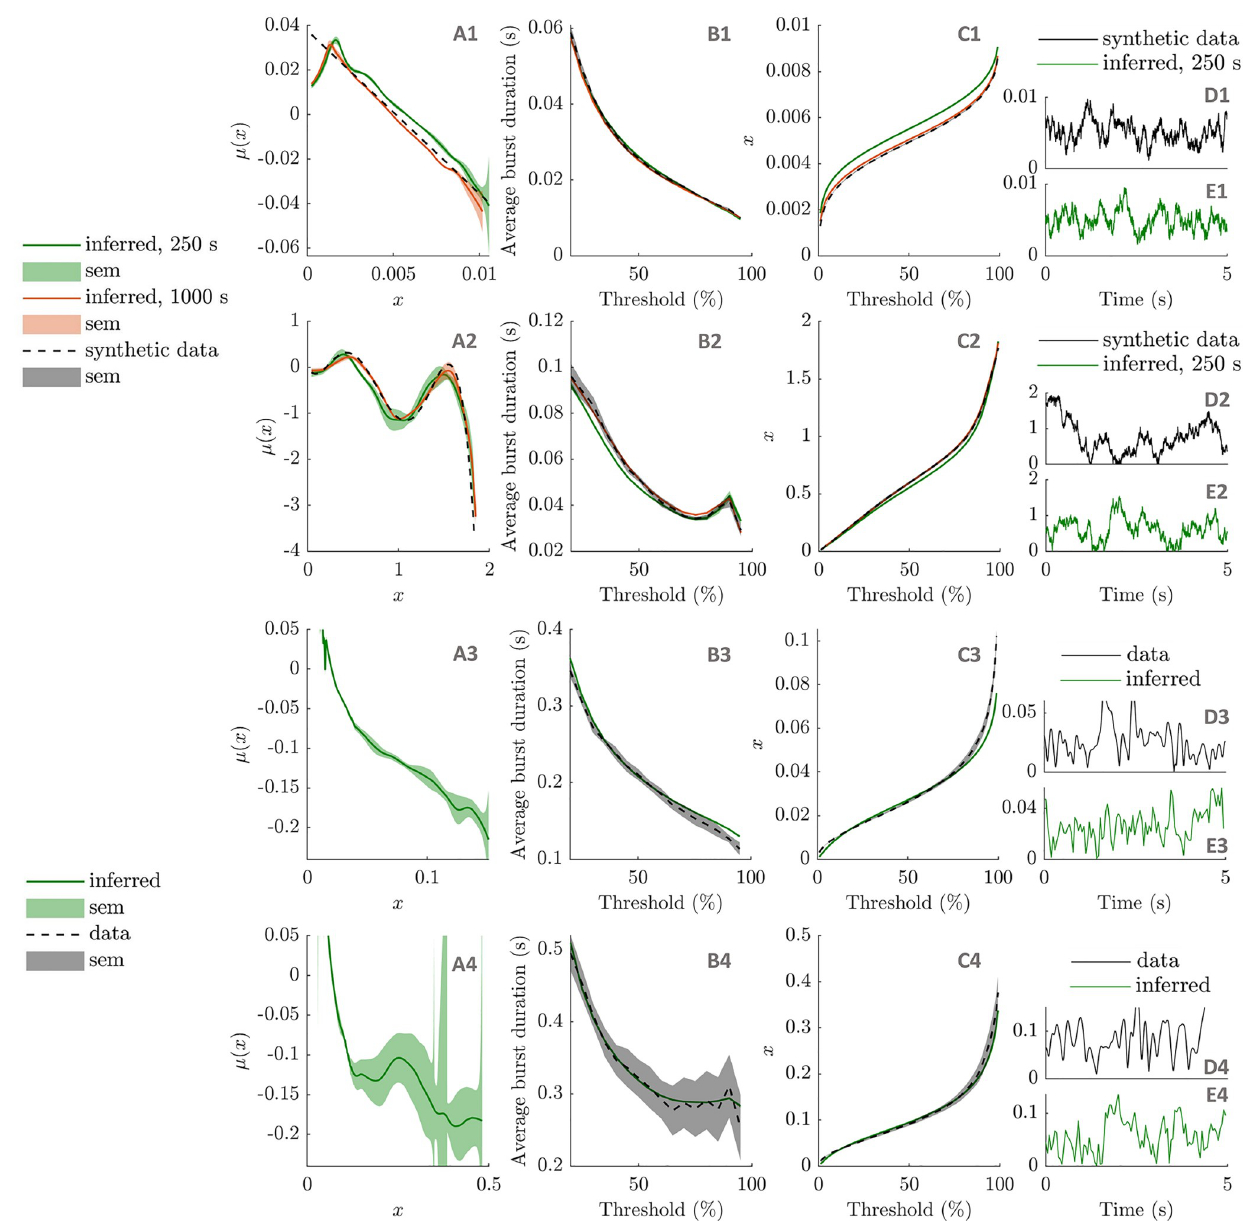
Fig 11. Inferring envelope dynamics with the passage method. The method is applied to synthetic data (OU model in the first row, fifth degree polynomial model in the second row), and patient data (patient 6R, ON medication in the third row, and patient 6R, OFF medication in the last row). The recovered drift functions ( μ ) are shown in the first column, and the average burst duration profiles and the inverse CDFs simulated from the recovered dynamics are shown in the second and third columns, respectively. Ground truths are provided when available (black dashed lines). Synthetic data results are presented for 250 s and 1000 s of synthetic data. In the last column, 5 s of simulated data from the recovered dynamics are compared to training